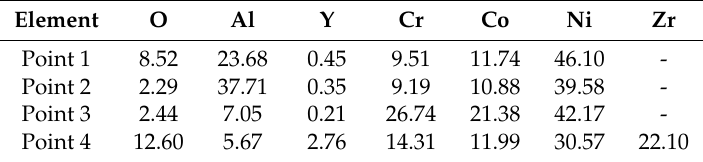
Table 3. Oxide inclusion contents of the alloys, based on the images of the longitudinal sections of the alloys (excluding the reaction layer).